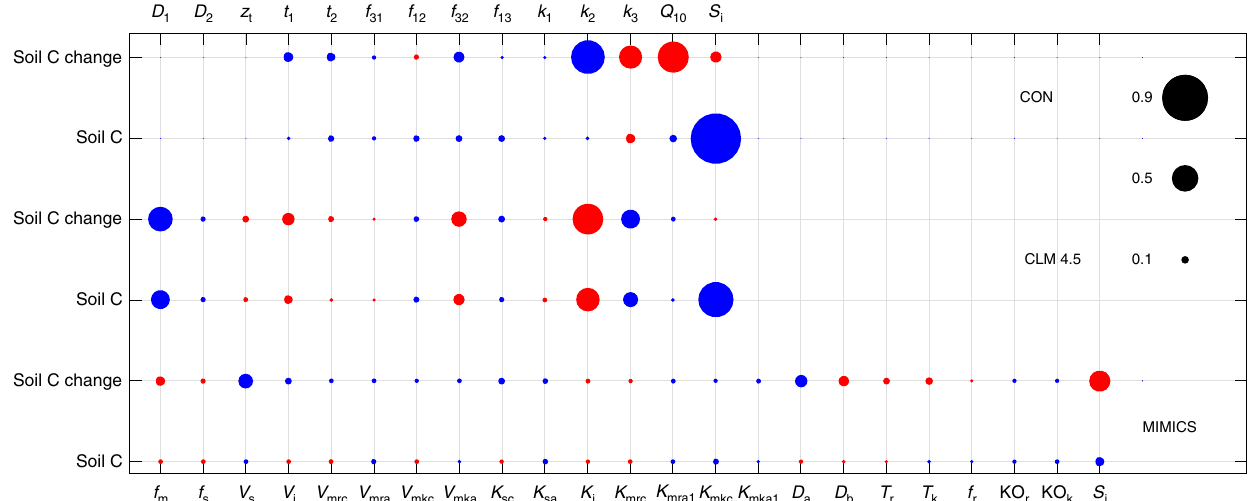
Fig. 5 The relationships between soil C, model parameters, and initial conditions. The linear correlations between soil C or C changes, and initial conditions ( S i ) and model parameters under RCP 8.5 in the three models. CON is the conventional Century-type model. Blue circles represent positive correlations and red circles represent negative correlations. The size of a circle is determined by the correlation coef fi cient between model parameters or initial conditions and soil C or C changes. The parameter labels on the top of the fi gure are for CON and CLM 4.5; the parameter labels at the bottom are for MIMICS. For the meanings of the parameters, please refer to Tables 1 and 2 and Supplementary Table